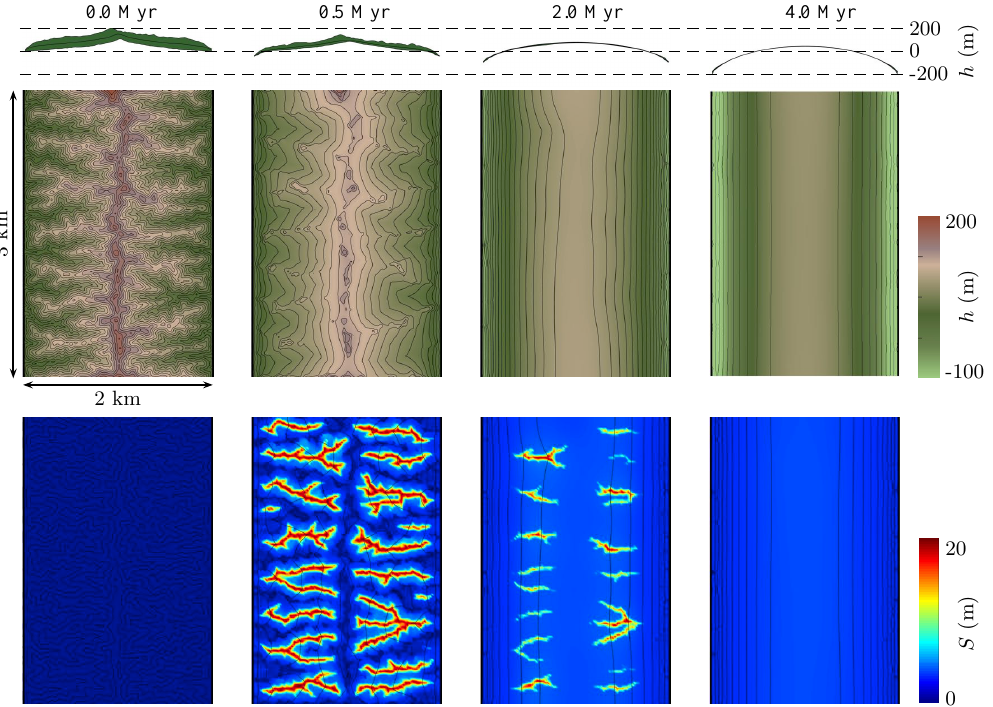
Figure 5. Same model experiment (no. 1) as in Fig. 4 but extended to 4Myr and showing average relief, topography, and sediment thickness over time. The model evolution is shown at 0, 0.5, 2, and 4Myr from left to right. Top panel: the topographic envelope of the landscape. Green area marks the difference between the minimum and maximum topography when measured along the long axis (3km) of the grid (black line indicates mean elevation). Note that the green area collapses over time because the initial local relief is removed by the periglacial processes. Middle panel: modelled topography in map view. Bottom panel: distribution of sediment in the simulated landscape. Note that the initial relief decays relatively rapidly, but traces of the initial relief are still preserved in the sediment distribution after 2Myr. However, the sediment thickness becomes uniform (3–4m) in the final stage of the simulation (4Myr), and the modelled landscape no longer carries any memory of its initial